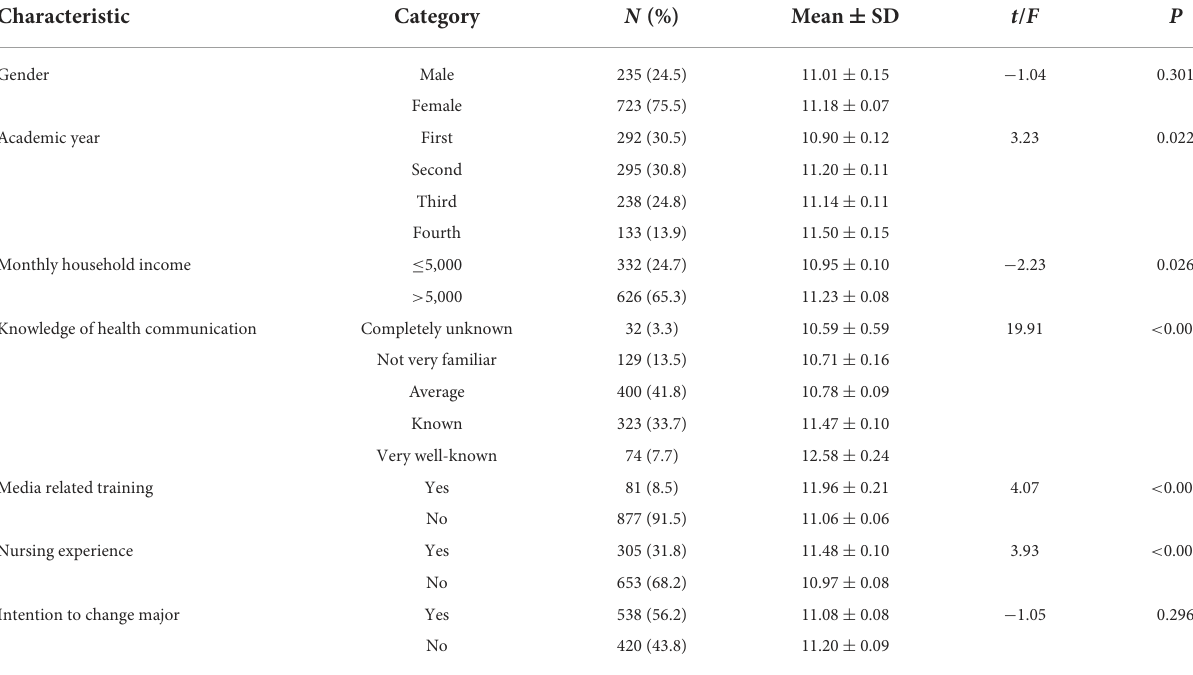
TABLE 1 Differences in general characteristics of participants’ intention to transmit health information ( N = 958). Characteristic